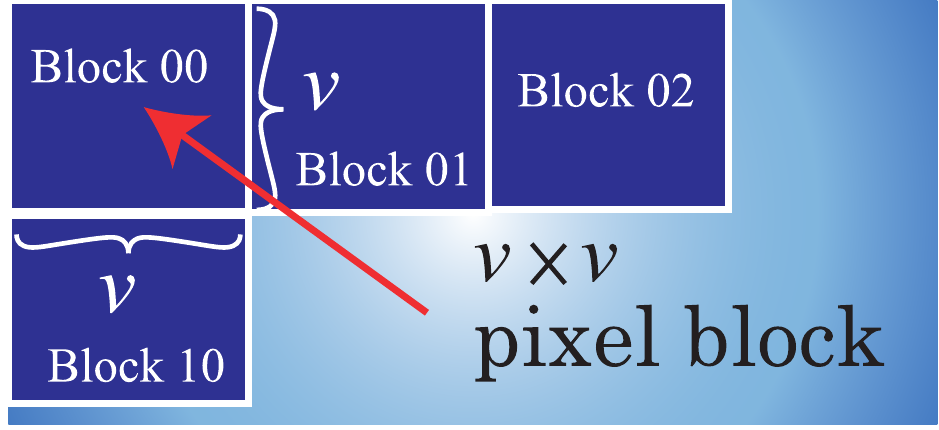
Figure 3. The definition of image data blocks input into the